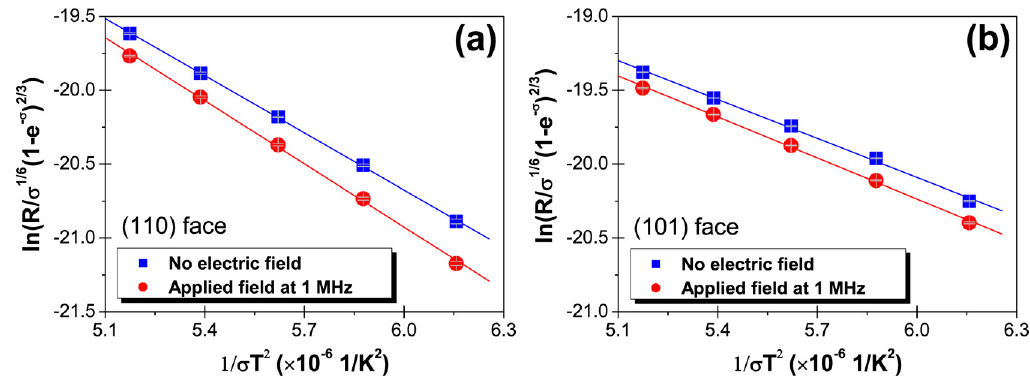
Figure 4. Growth rate R with and without external electric field as function of 1/ ( σ T 2 ) . ( a ) (110) face and ( b ) (101)